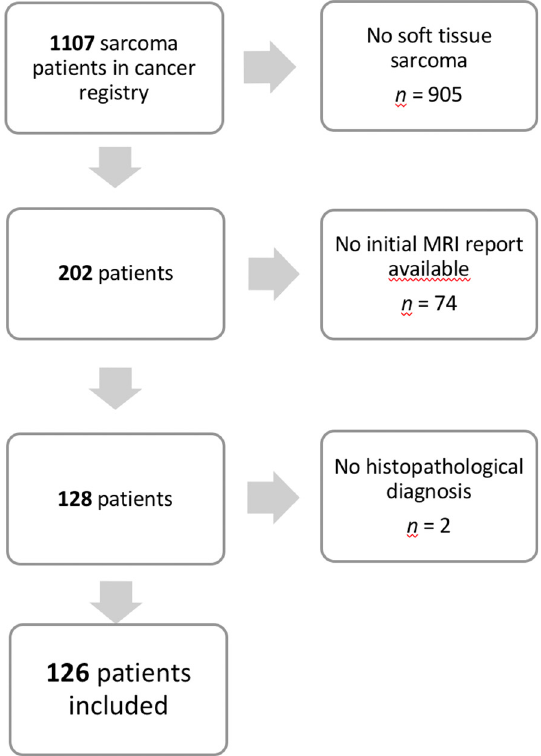
Figure 1. Flow chart of our study cohort. After removal of duplicates, 1107 patients with soft tissue sarcomas were listed in our cancer registry for biopsy or excision surgery between 2012–2018.